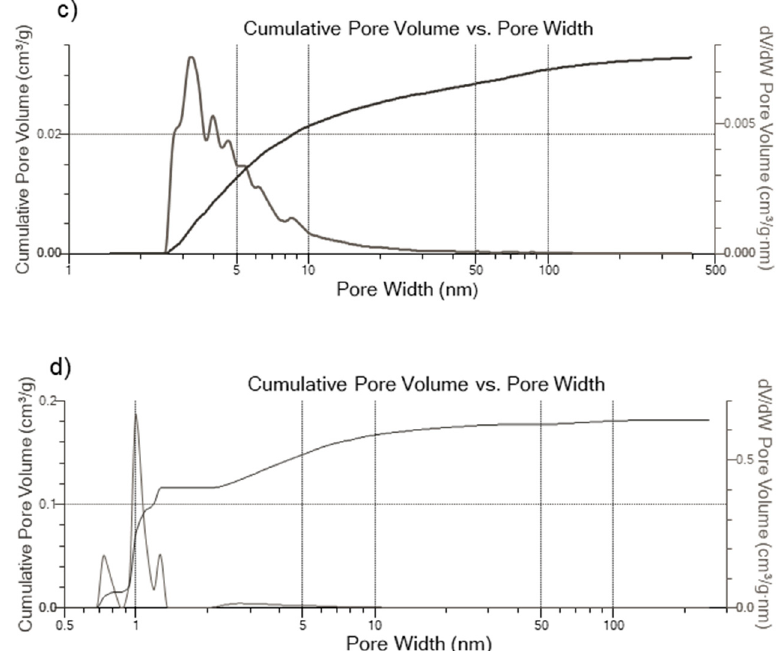
Figure A1. Cumulative pore volume and pore size distribution plots obtained using DFT function for ( a ) willow BC acid washed ( b ) willow AC acid washed ( c ) willow BC sulfonated ( d ) willow AC sulfonated.